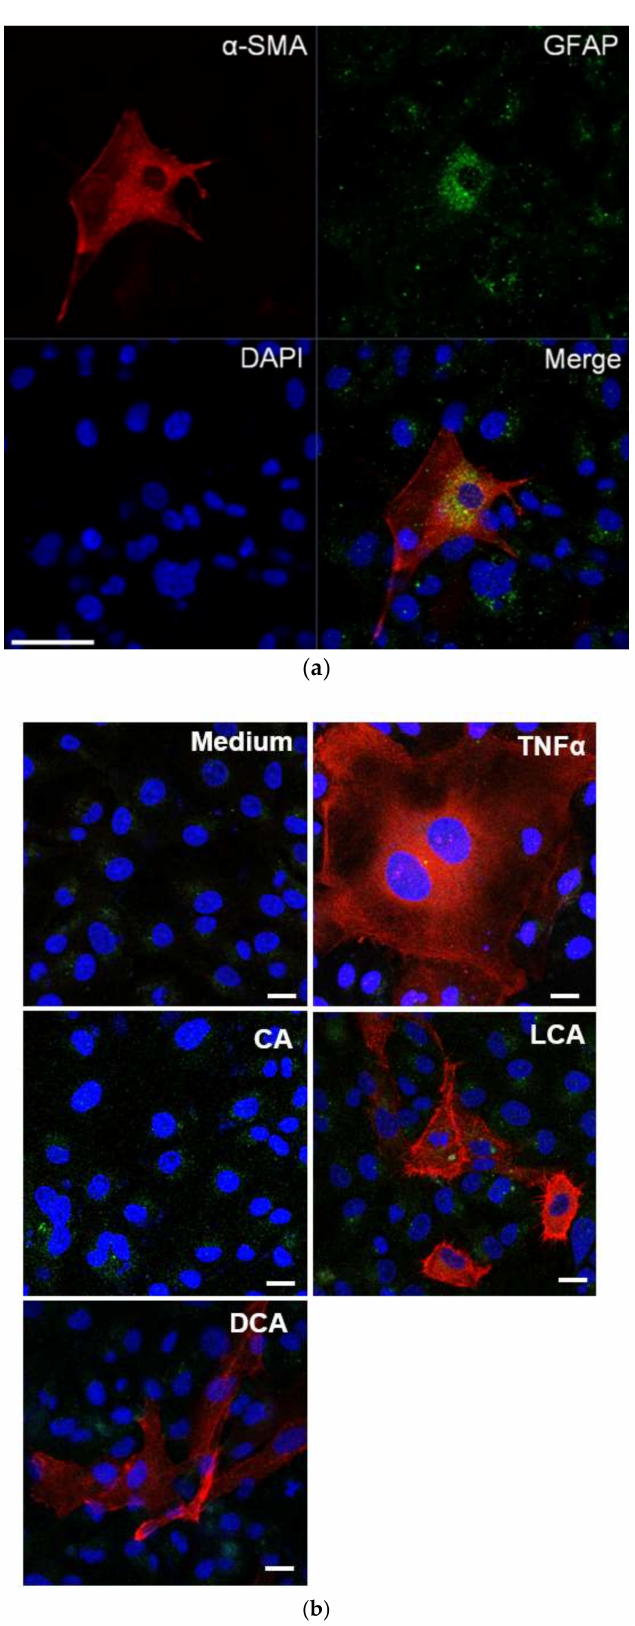
Figure 6. ( a ) Distribution of α -smooth muscle actin ( α -SMA; red) and glial fibrillary acidic protein (GFAP; green) in LX-2 cells exposed to bile acids. LX-2 cells were cultured with 500 µ M DCA and